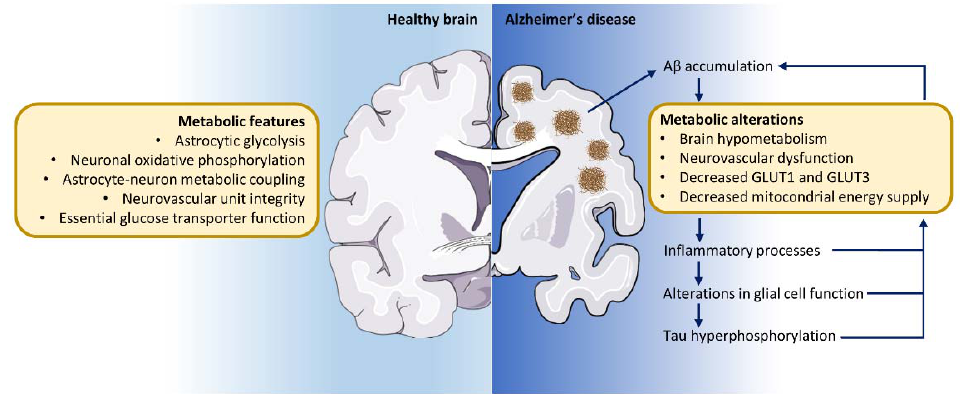
Figure 2. Metabolic alterations contribute to Alzheimer’s disease pathology. The metabolic coupling between astrocytes and neurons sustains proper brain function in the healthy brain. In the course of Alzheimer’s disease, at least 15 years before the onset of symptoms, a marked glucose hypometabolism is detected in specific brain regions. The accumulation of A β exacerbates brain glucose hypometabolism, both directly within the area of A β accumulation as well as in remote regions. In turn, this hypometabolic state triggers inflammatory processes and cellular damage. Moreover, alterations in glial cell function together with tau phosphorylation and subsequent accumulation exacerbates brain metabolic breakdown. Together, these features perpetuate a vicious cycle of neurodegeneration and declining brain glucose metabolism that contributes not only to the deterioration of memory and cognition but also to abnormal behavior in affected patients.